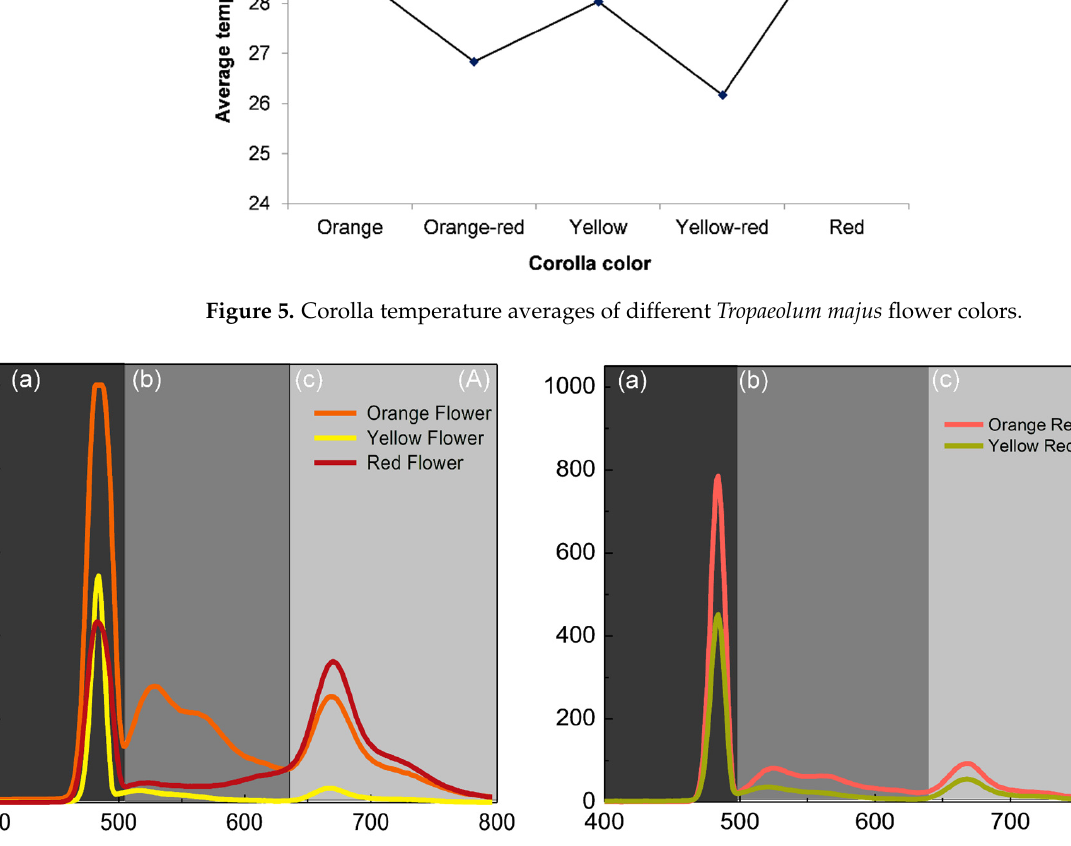
phyll a and b fluorescence, respectively [54]. Thus, we noted that red corolla flowers have a peak at 480 nm, which is smaller than those of orange and yellow corolla flowers (Figure 6Aa), and a larger peak at 670 nm, which is attributed to chlorophyll a and b fluorescence (Figure 6Ac).